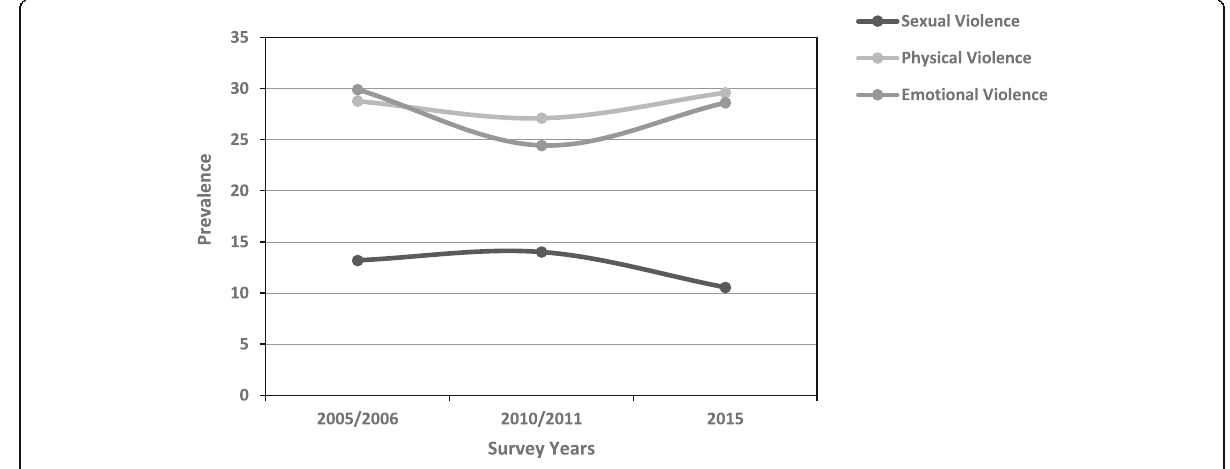
Fig. 1 Prevalence of IPV among women of reproductive age (15 – 49 years) by survey year, Zimbabwe, pooled data, 2005 – 2015